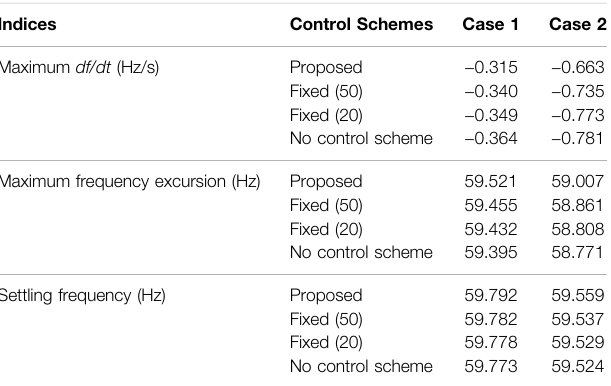
TABLE 1 | Summary of case 1 and case